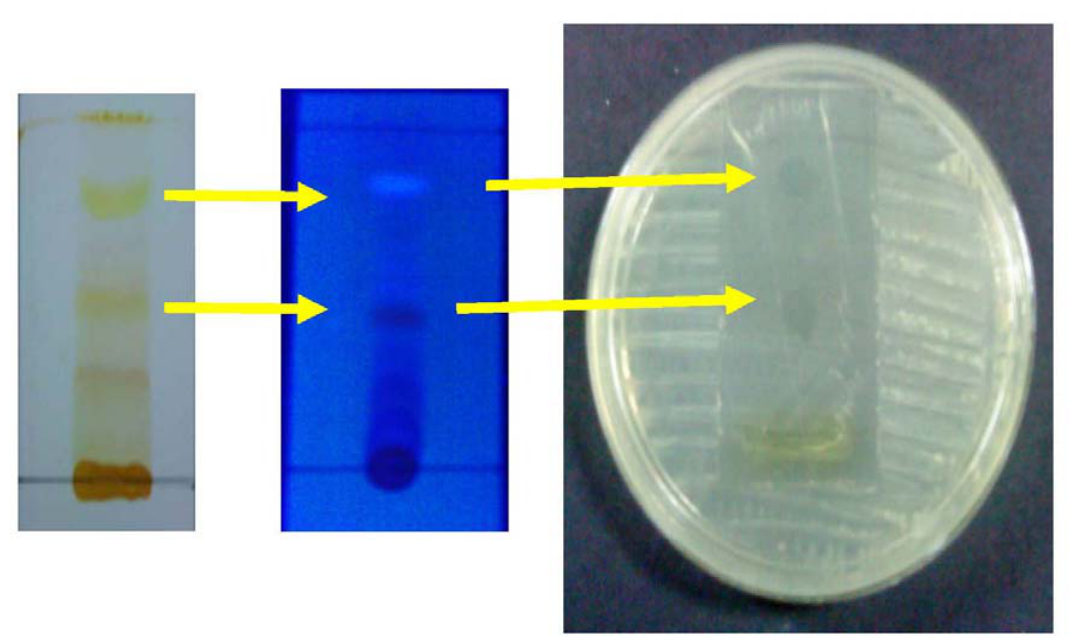
Figure 1. TLC bioautogram showed the band with antiyeast activity against C. albicans at the position of R 0.63. f